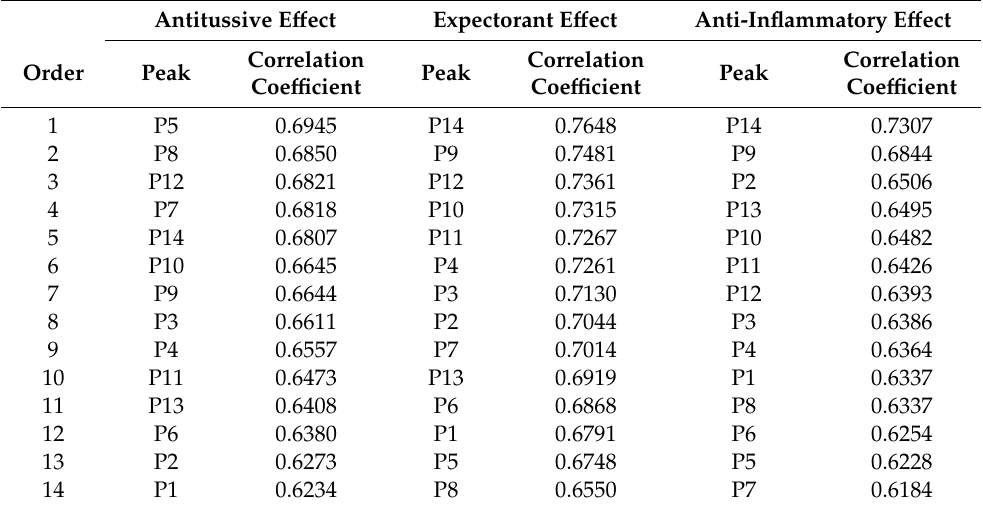
Table 5. Grey relational analysis (GRA) results of antitussive, expectorant, anti-inflammatory